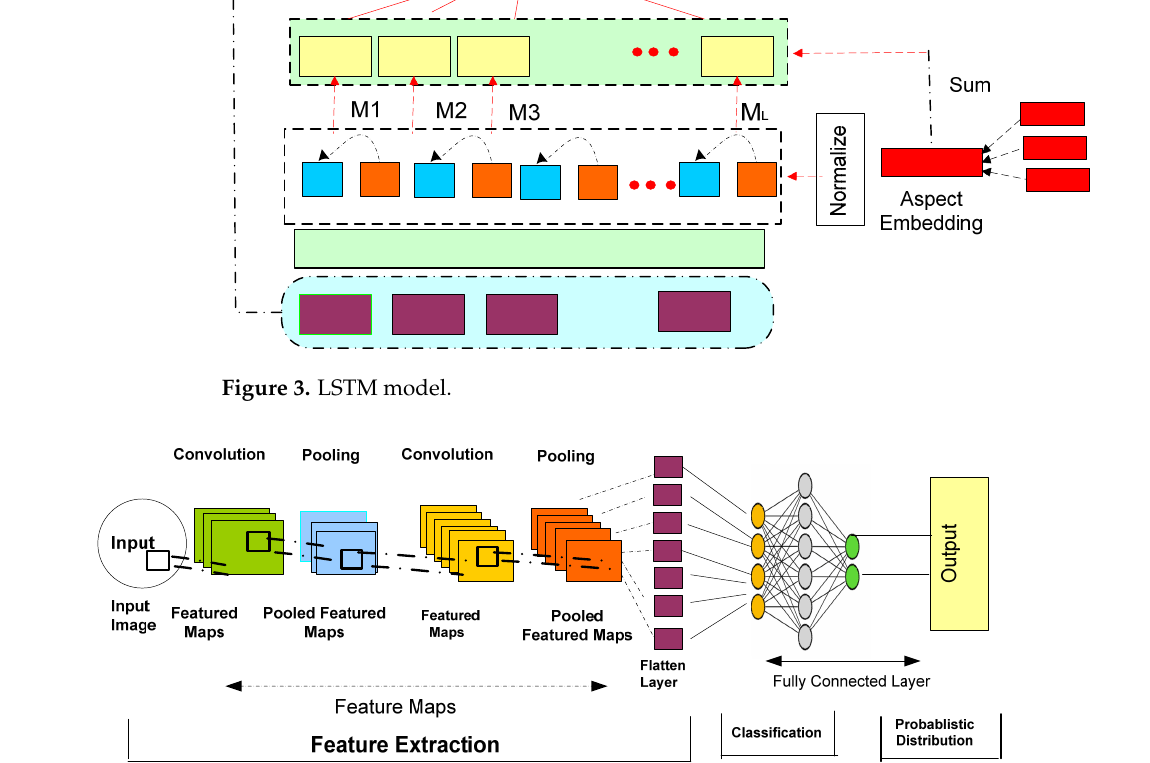
Figure 4. DRNN architecture .